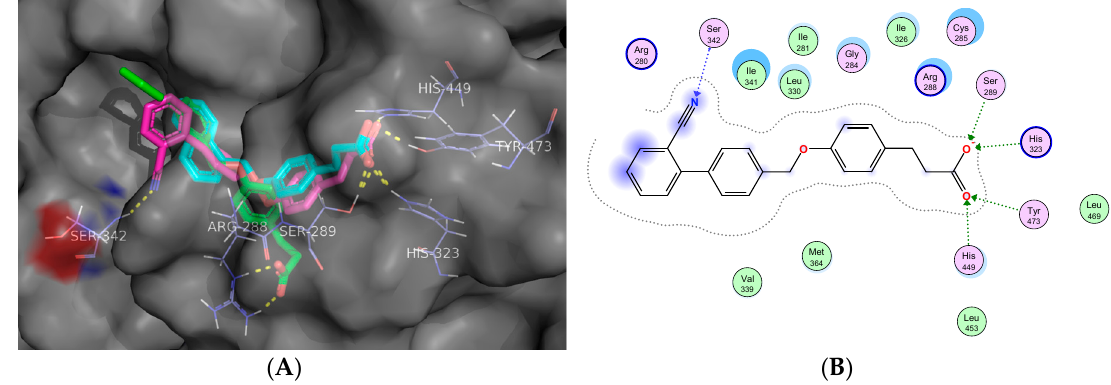
Figure 3. ( A ) 3D binding model of compounds 1 – 3 into the ligand binding site of PPAR γ . Compounds are presented as stick models: 1 (green), 2 (cyan) and 3 (magenta), and aminoacids as lines. Dashed line signifies polar interactions; ( B ) 2D interaction map of the most active compound 3 and PPAR γ .